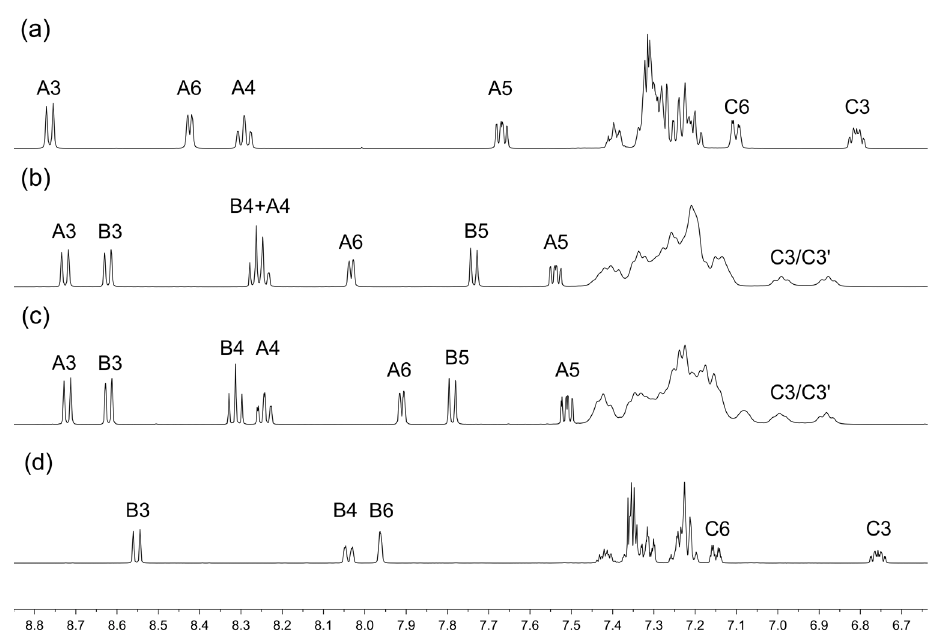
Figure 1. 1 H-NMR spectra (aromatic regions, 500 MHz, acetone- d 6 , 298 K) of ( a ) [Cu(BIPHEP)(bpy)][PF 6 ], ( b ) [Cu(BIPHEP)(6-Mebpy)][PF 6 ], ( c ) [Cu(BIPHEP)(6-Etbpy)][PF 6 ] and ( d ) [Cu(BIPHEP)(5,5'-Me 2 bpy)][PF 6 ].